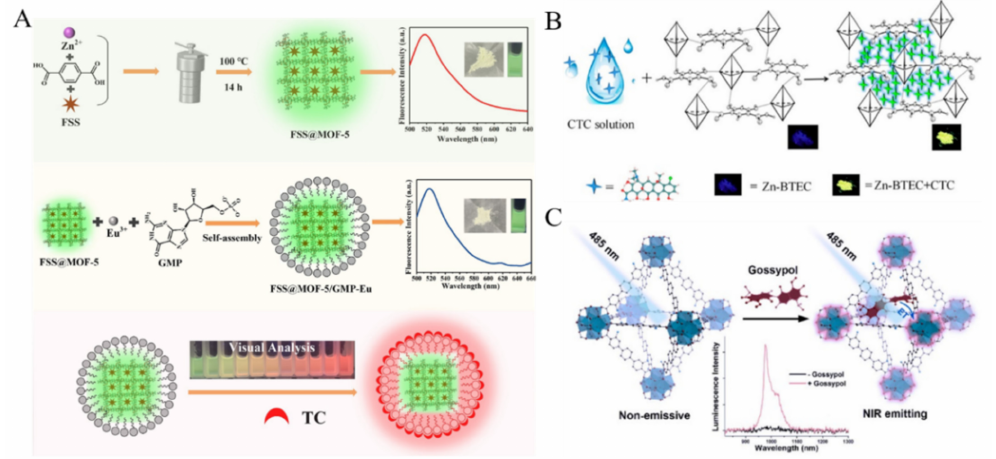
Figure 8. ( A ) Schematic illustration of the synthesis process of FSS@MOF-5/GMP-Eu for rapid and visual detection of TC. Reproduced with permission [134]. Copyright 2021, Elsevier. ( B ) Schematic illustration of sensing process for CTC using MOF Zn-BTEC as a fluorescent probe based on AIE mechanism. Reproduced with permission [136]. Copyright 2019, American Chemical Society. ( C ) Schematic illustration of fluorescent “turn-on” detection of gossypol using Ln 3+ -based MOFs